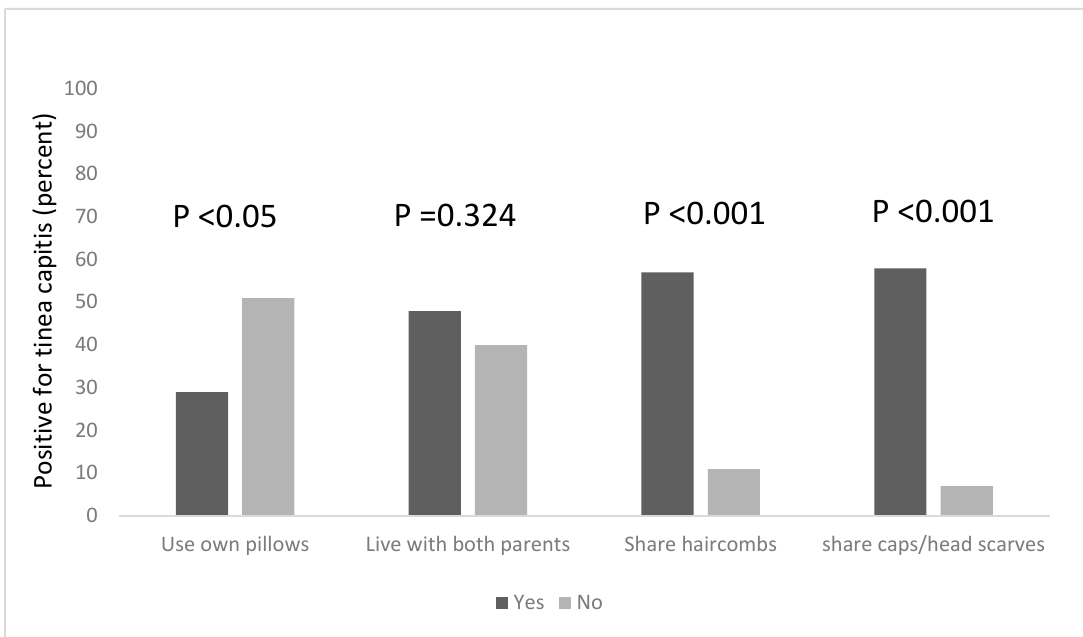
Figure 1. Risk factors associated with the occurrence of tinea capitis among the participants, based on the sharing of personal items and clothing.